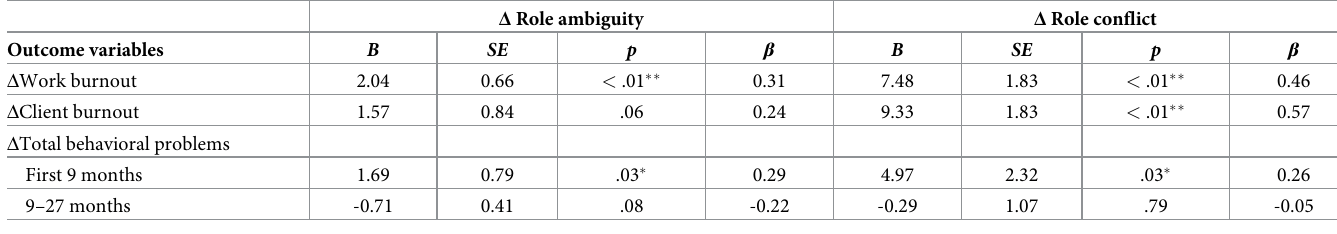
Table 3. Regression estimates of changes in staff burnout and total behavioral problems on changes in role ambiguity/conflict. Δ Role ambiguity Δ Role